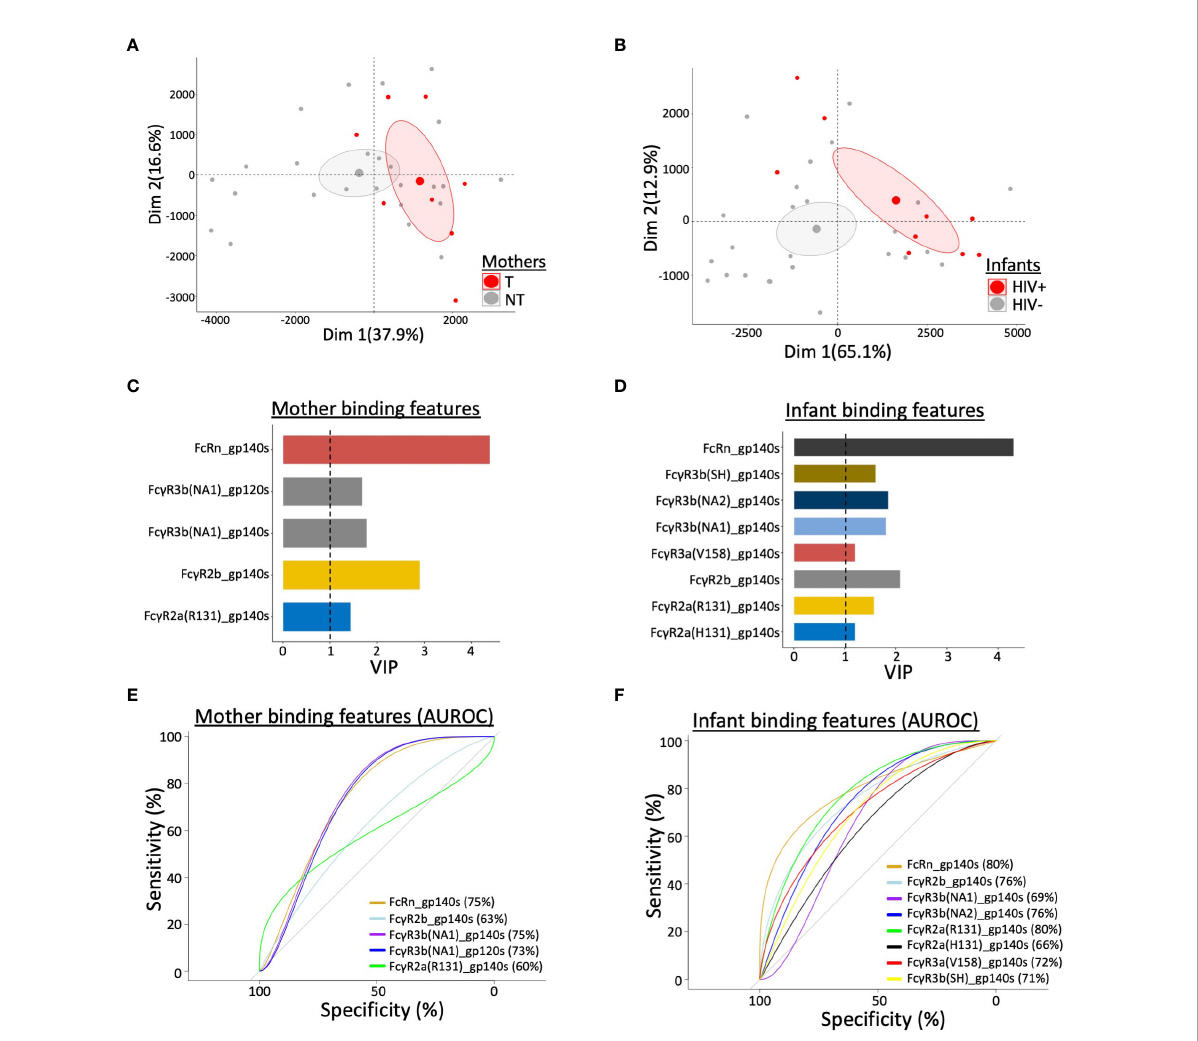
FIGURE 5 Multivariate statistical analysis of antibody features that predict vertical transmission of HIV. Principal component analysis (PCA) of antibody pro fi ling strati fi ed by (A) mother ’ s transmission status for transmitting (T) and non-transmitting (NT) mothers and (B) infant ’ s HIV status for HIV+ and uninfected (HIV-) infants. Ellipses correspond to 95% con fi dence intervals for each group. Variable Important Projection (VIP) scores, through Partial Least Square Discriminant Analysis (PLSDA), indicate the capability of contributing to the model in terms of separating (C) mothers by transmission status and (D) infants by infection status. VIP score > 1 was used as threshold to select the most contributing features among all binding features in study. Area under the receiver operating characteristic curve (AUROC) shows the predictive ability of selected features to separate (E) T and NT mothers, and (F) HIV+ and HIV- infants. AUC values are indicated in each